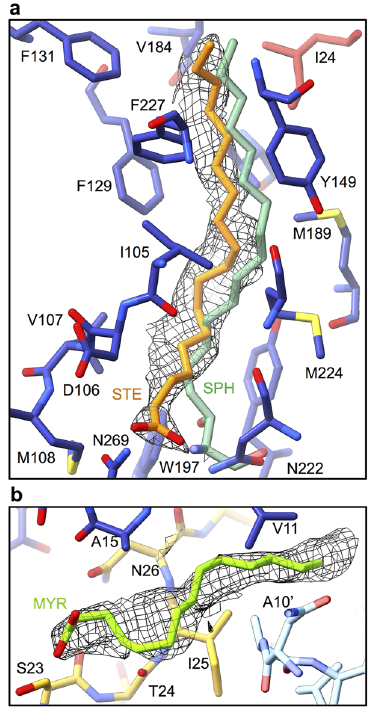
Fig. 3 Pocket factor and myristate in CV-A6 virion. a Pocket factor binding site in VP1 pocket of CV-A6. The proteins and lipid are shown in stick representation. Residues of VP1 are shown with carbon atoms coloured in blue, VP3 in red, and the CV-A6 pocket factor stearic acid in orange. For comparison, the pocket factor of poliovirus 1, sphingosine (PDB 1ASJ) 39 , is shown in light green. The density of the CV-A6 pocket factor is shown as a grey mesh. b Putative myristate attached to N-terminus of VP4 is shown in green. The density of the myristate is depicted as a grey mesh. The myristate interacts with residues of two VP1 subunits (blue, light blue) and VP4